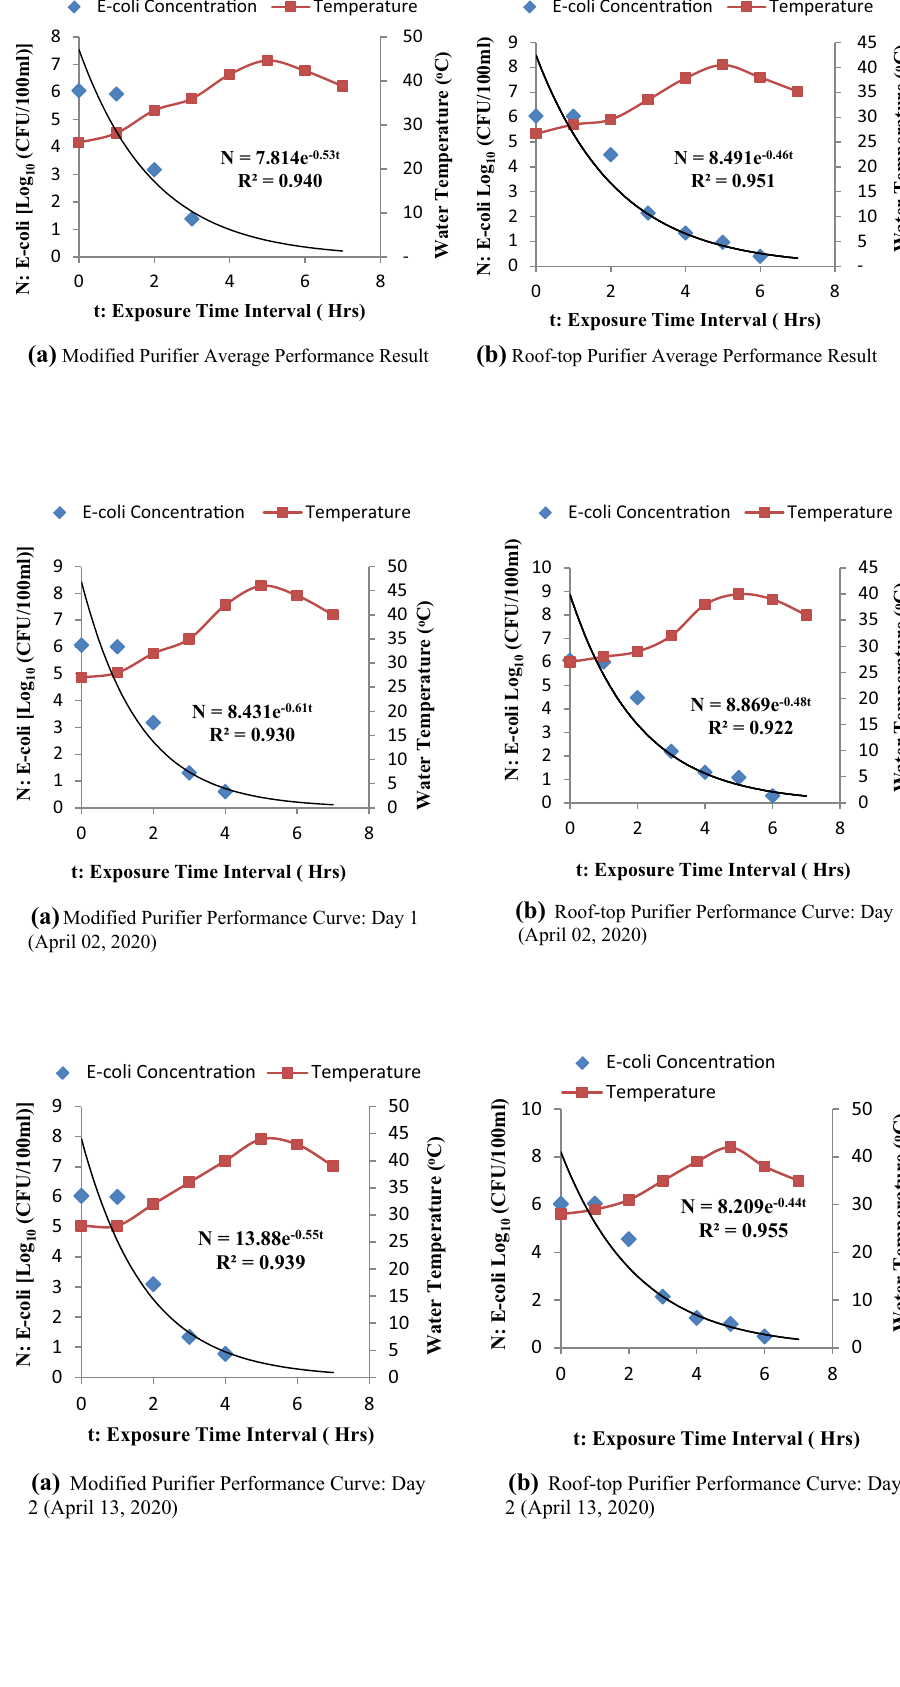
Fig. 7 a and b Average deacti- vation curve of E. coli concen- tration in water samples inside PET bottles exposed to sunlight on the improved SODIS and the conventional SODIS, respec- tively. Note: N is in Log10 units N = 7.814e -0.53t